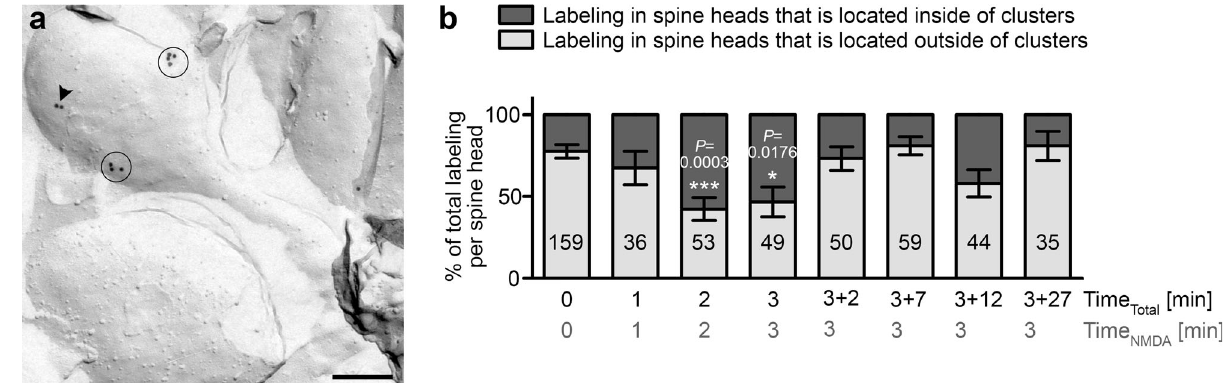
Fig. 5 The initial minutes of LTD induction are marked by PIP2 clusters transiently occurring in spine heads. a Example TEM image of a cryo-preserved, freeze-fractured and anti-PIP 2 immunogold-labeled spine of a primary hippocampal neuron treated with NMDA for 3 min. Clustered ( n ≥ 3 gold particles in a circular ROI with a diameter of 100 nm) and (more) disperse anti-PIP 2 signals in the spine head are marked with circles and an arrowhead, respectively. Bar, 200 nm. b Quanti fi cation of the distribution of anti-PIP 2 immunogold labels in spine heads found within a cluster compared to labels outside of any cluster (in percent of total labeling found at the spine head membrane). Note the transient increase in clustering 2 and 3 min into NMDA treatment. Data, mean ± SEM. 0 min, n = 159; 1 min, n = 36; 2 min, n = 53; 3 min, n = 49; 5 (3 + 2) min, n = 50; 10 (3 + 7) min, n = 59; 15 (3 + 12) min, n = 44; 30 (3 + 27) min, n = 35 ROIs (spine head) each from 3 to 16 independent assays with different incubation times. Two-way ANOVA/ Š ídák ’ s Multiple Comparison test (comparisons to 0 min). * P < 0.05; *** P < 0.001. P -values are reported directly in the fi gure. For numerical source data, see Supplementary Data